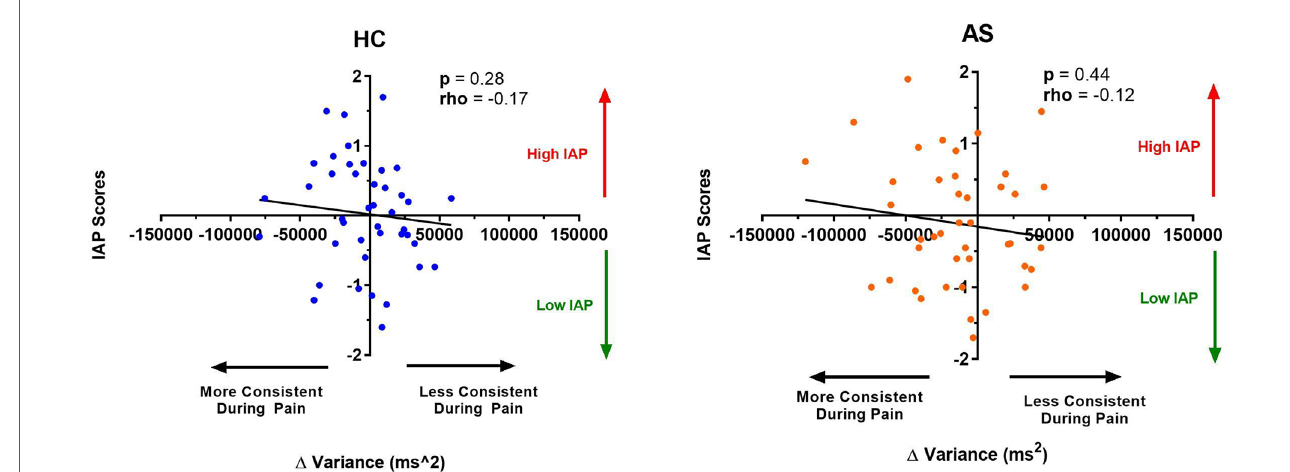
FIGURE 7 Relationship between an individual ’ s intrinsic attention to pain (IAP) and the effect of pain on variance in task reaction time (RTv). No signi fi cant correlation was found between the IAP scores and the Δ RTv in the healthy controls (HCs) (left panel) or for the ankylosing spondylitis (AS) group (right panel). The HCs are represented by the blue dots. The AS group is represented by the orange dots. More consistent RTs during pain is represented by a negative Δ RTv value (values that are on the left side of the horizontal axis). Less consistent RTs during pain is represented by a positive Δ RTv value (values that are on the right side of the horizontal